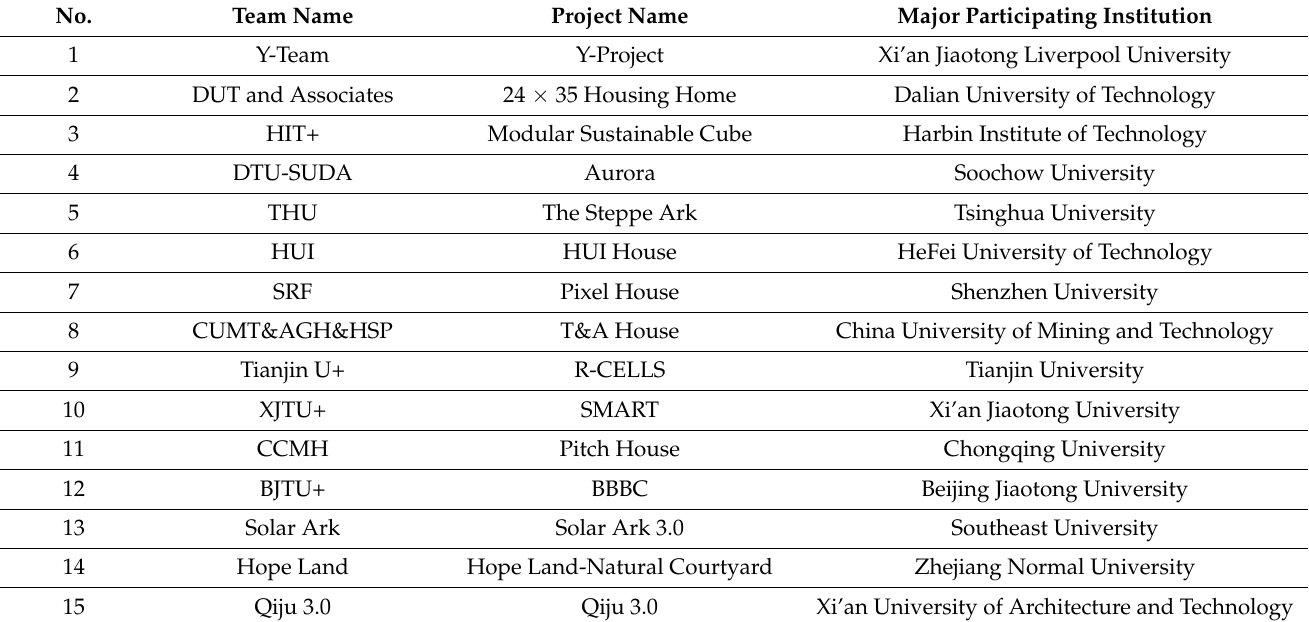
Table 1. Entries and team information of the third Solar Decathlon China.